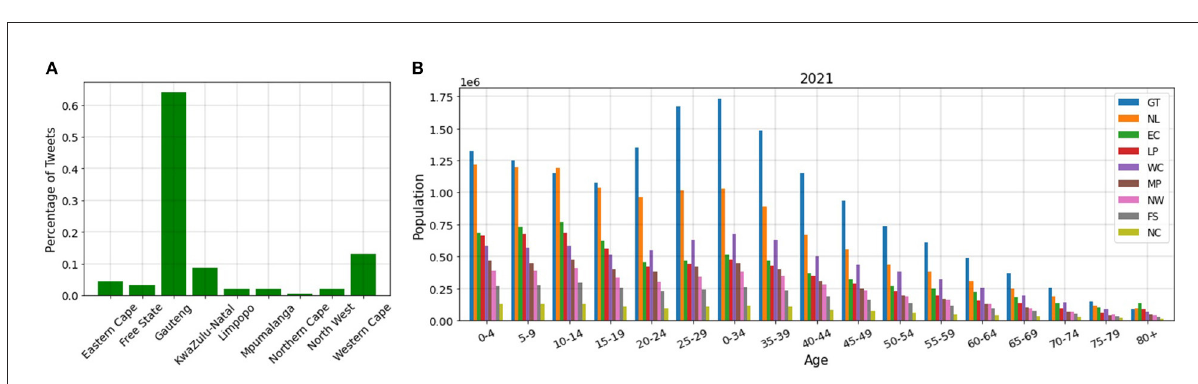
people of working ages (20–60 years old) live in the